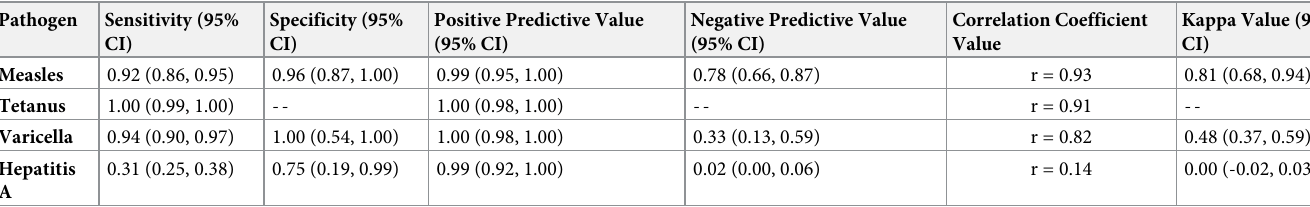
Table 1. Statistical comparison between serum and DBS